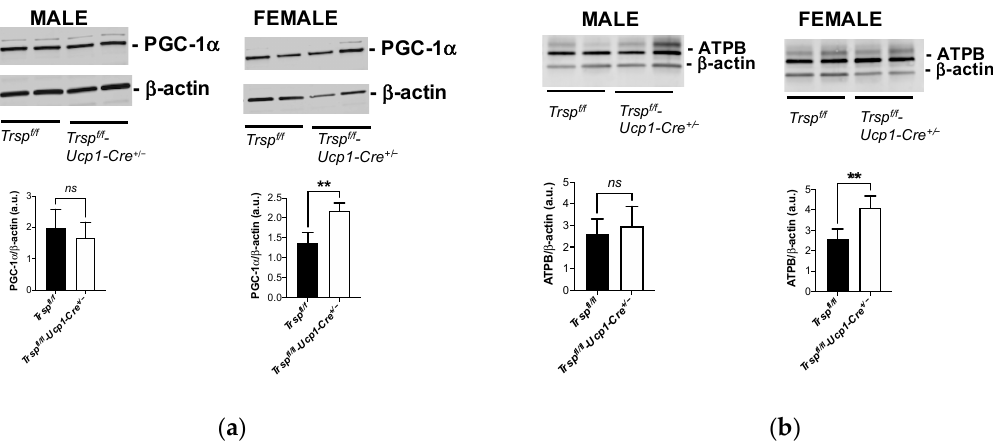
Figure 4. BAT mitochondrial markers in Trsp f/f -Ucp1-Cre +/ − mice. Levels of mitochondrial markers ( a ) PGC-1 α and ( b ) ATPB in BAT of male and female Trsp f/f -Ucp1-Cre +/ − mice were assessed by Western blot ( n = 8 per sex). Values are mean ± SD and p -values were calculated using unpaired Student’s t -test. ns , non-significant, ** p < 0.01.